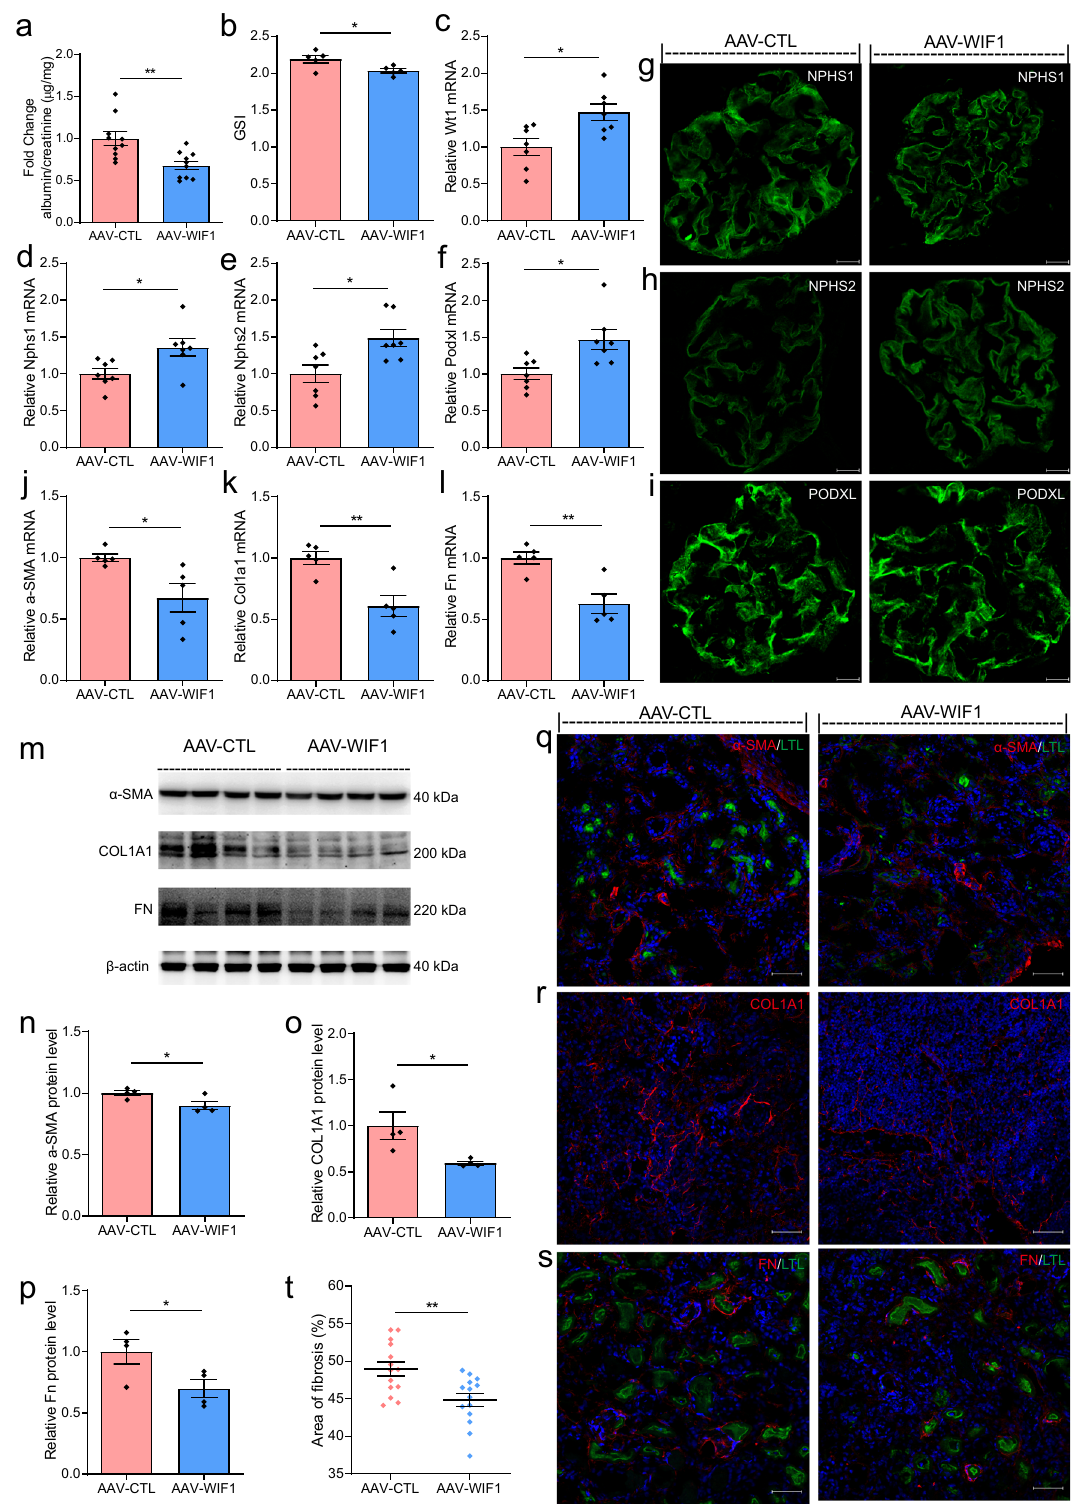
Histologic analysis . Paraf fi n-embedded mouse kidney sections (5- μ m thickness) were prepared by a routine procedure. Sections were stained with Hematoxylin and Eosin (H&E), Sirius Red, PAS, and MTS. Histology images were collected by cellSens Software v3.1. PAS-stained sections were examined for the degree of glomerular damage (GSI and mesangial area expansion) using a semiquantitative scoring method as described by Maric et al. 32 . Image J v1.8.0 was used to quantify PAS staining micrographs. MTS sections were examined for the degree